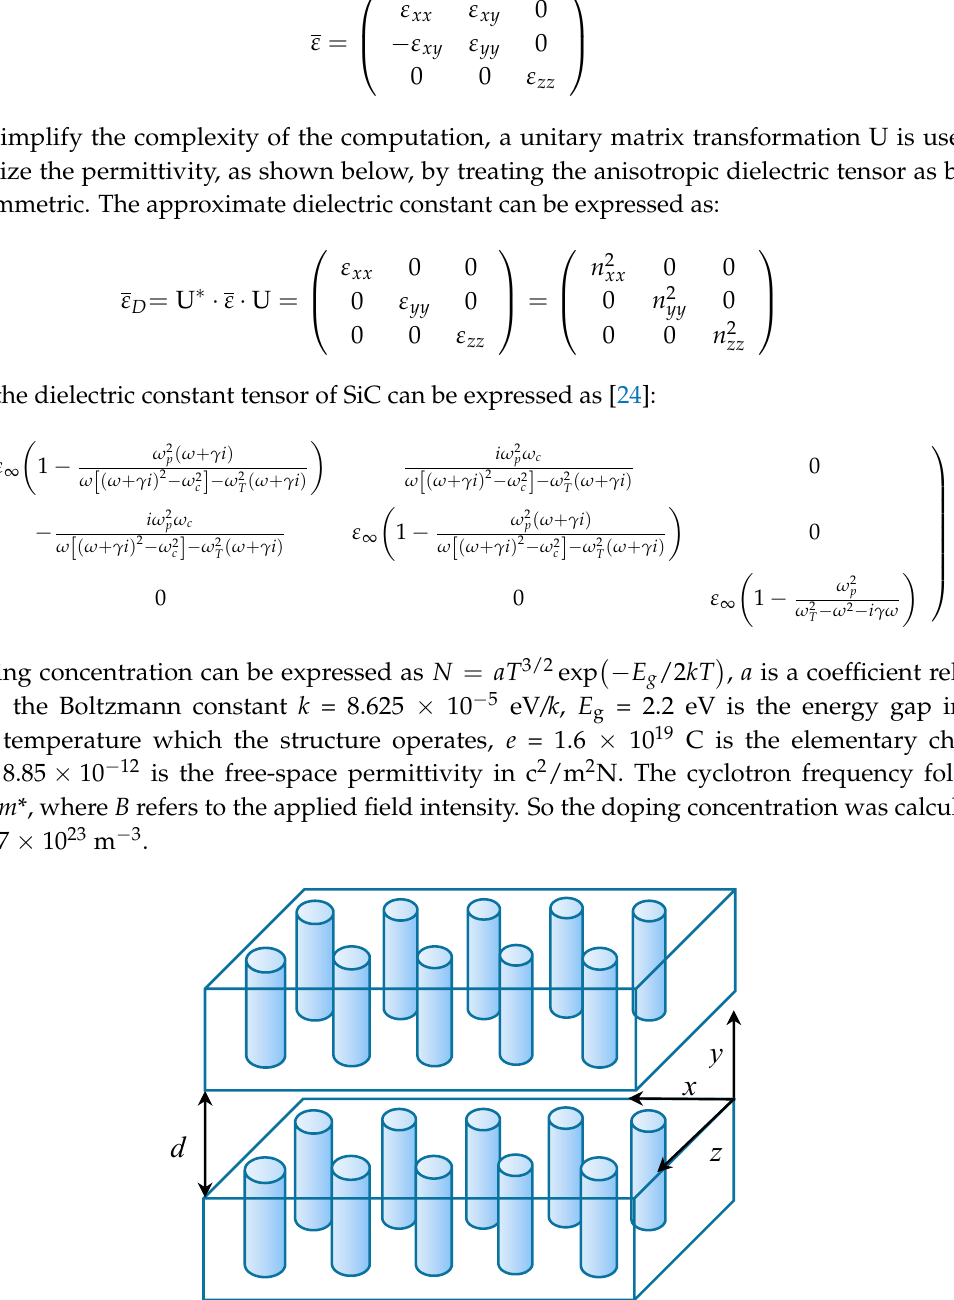
Figure 1. Schematic of radiative heat transfer between two-infinite SiC nanowires separated by a vacuum gap d .